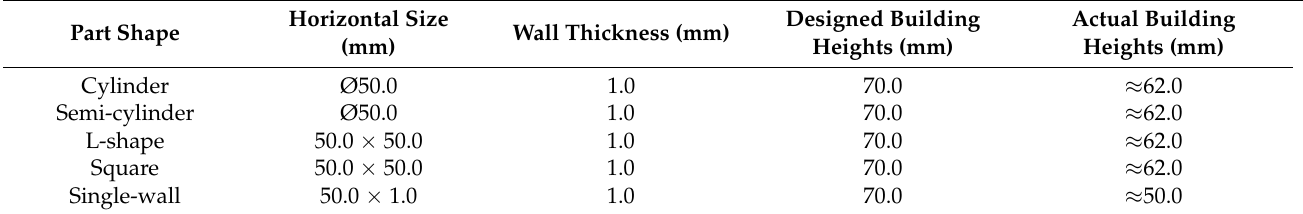
Figure 4. Thin-walled structures: nominal CAD model in blue, while printed parts are depicted in yellow color. The roughness of the top surfaces induced by the recoater is highlighted in red. (W1, W2, etc. are the sample names.) Table 4. Geometrical dimensions of different thin-walled structures.